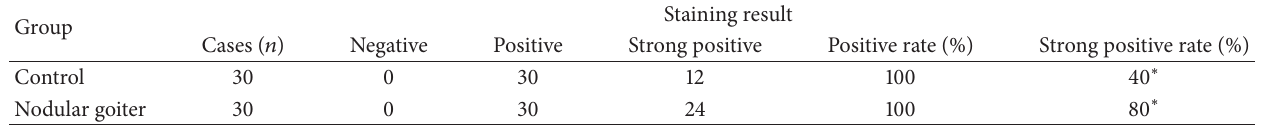
Table 2: Immunohistochemistry detecting TTF-1 in control and nodular goiter groups.